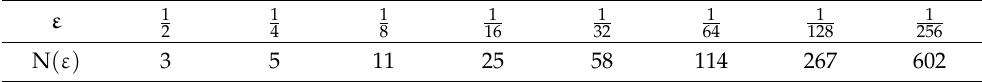
Table 1. Determination of N ( ε ) by box-counting